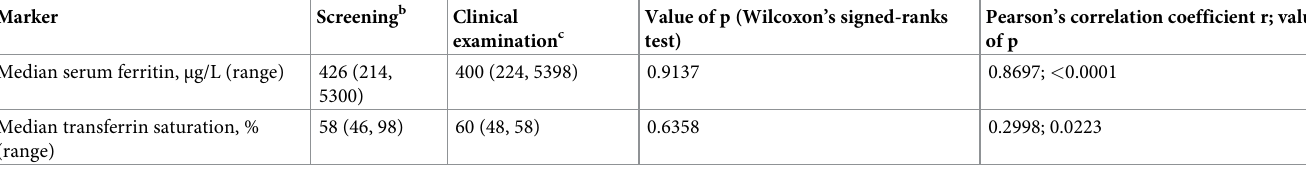
Table 1. Elevated SF and elevated TS in 58 non-Hispanic white participants without HFE p.C28Y/ p.C282Y a .